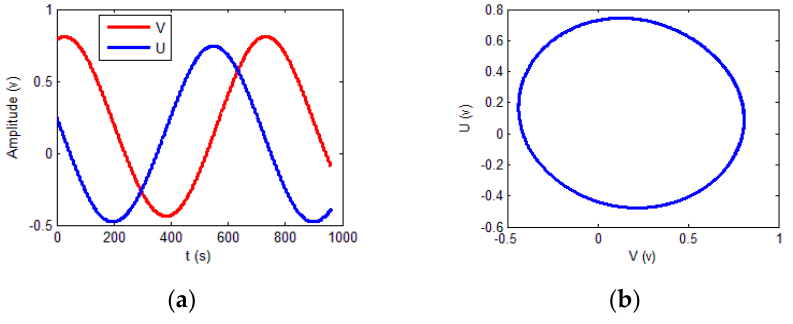
Figure 16. Signals for experiment. ( a ) Sinusoidal and cosine signals; ( b ) Lissajous figure for the output